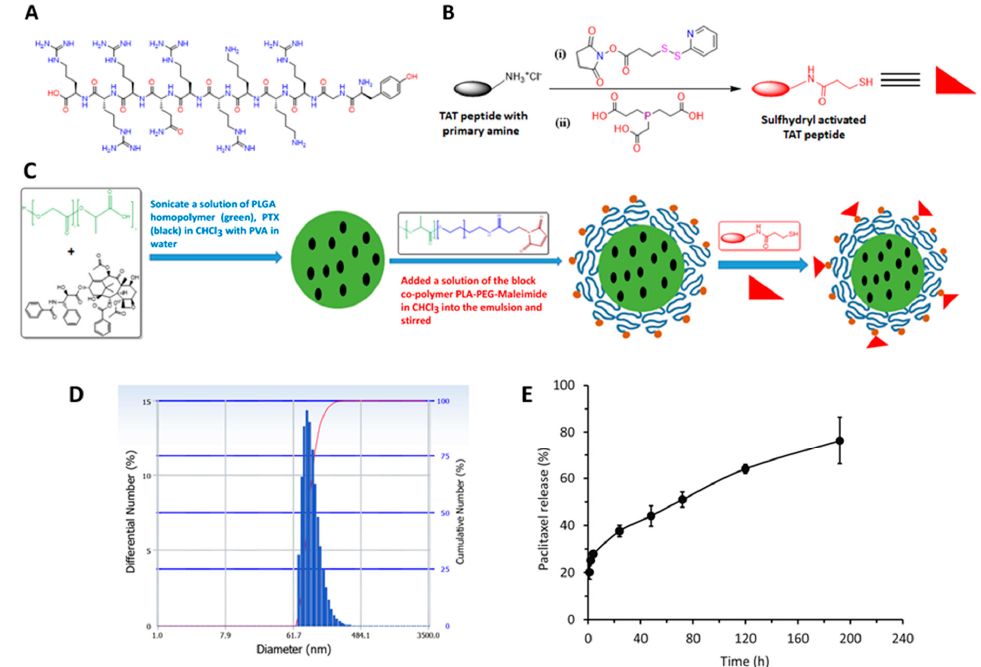
Figure 1. Preparation and characterization of PTX loaded TAT functionalized PLGA nanoparticles (TAT PTX NP). ( A ) Chemical structure of HIV-1 TAT peptide (47–57, YGRKKRRQRRR). ( B ) Synthetic scheme for the preparation of sulfhydryl activated TAT peptide using SPDP and TCEP. ( C ) Diagrammatic representation for the preparation of TAT PTX NP. ( D ) Particle size distribution of TAT PTX